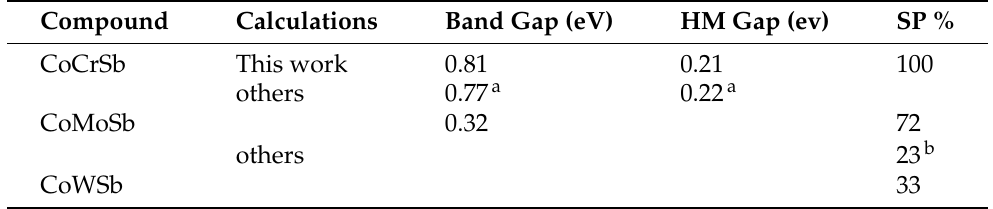
Figure 4. Band structures for CoMoSb ( a ) majority-spin and ( b ) minority-spin. The Fermi level is indicated by the dashed horizontal line. Table 4. The calculated minority-spin band gap, half-metallic (HM) gap, and % spin polarization (SP) of Type I CoYSb (Y = Cr, Mo, W).